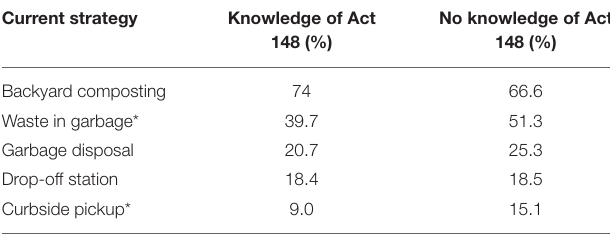
TABLE 2 | Current food waste strategy as a function of knowledge about Vermont’s food waste